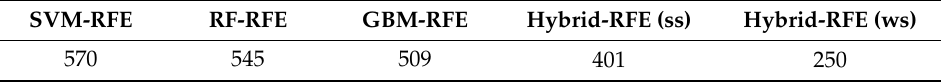
Table 5. Average number of selected features from the GDS